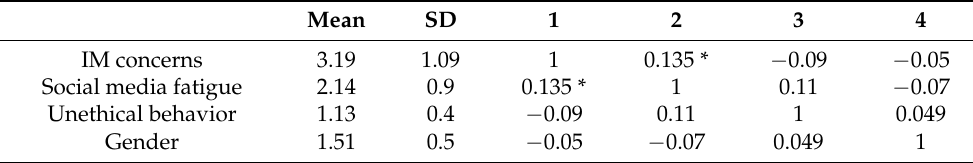
Table 3. Study 2: mean, standard deviation, and intercorrelations. Mean SD 1 2 3 4